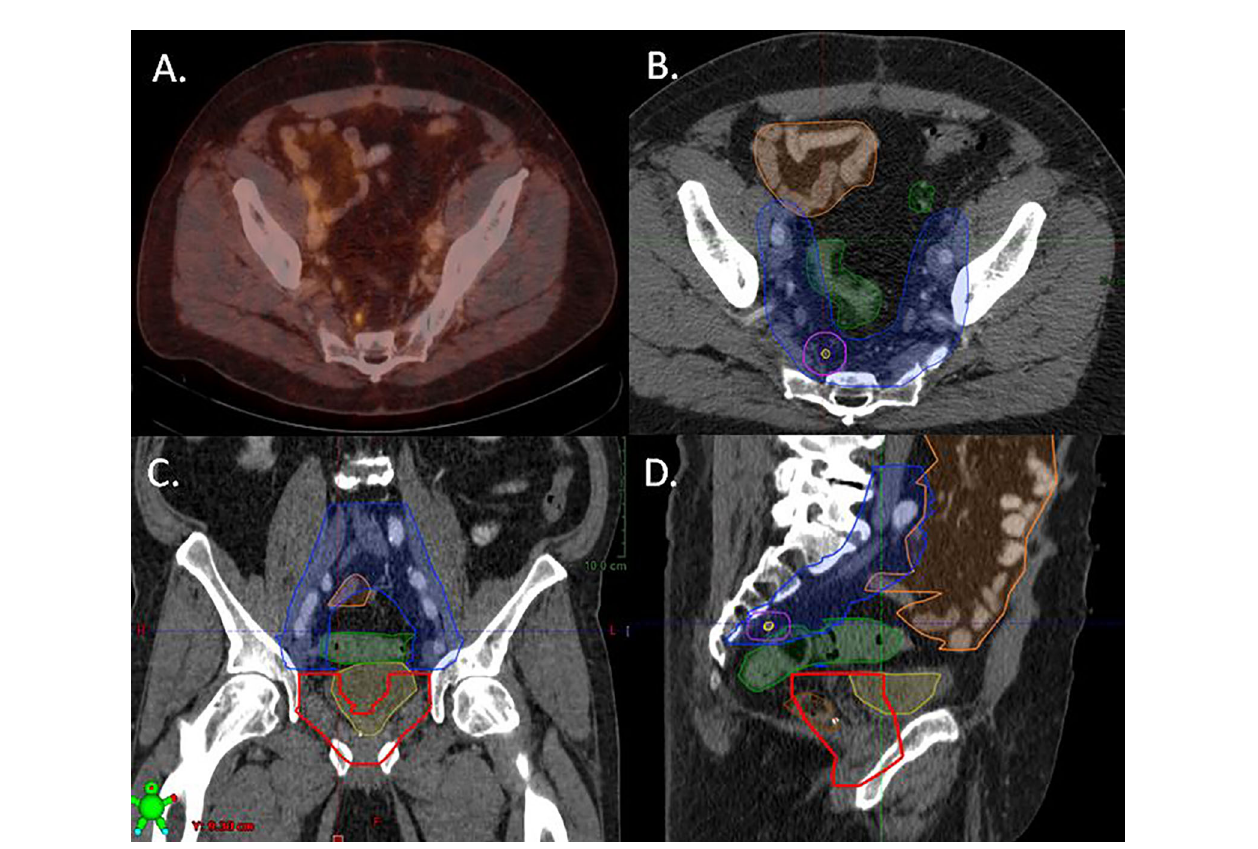
FIGURE 1 | Treatment plan of a patient with a presacral lymph node recurrence on PSMA-PET/CT illustrating the different target volume concepts. The patient was treated with elective prostate bed RT (ePBRT) and elective bilateral lymphatic RT with dose escalation to the PET/CT positive lymph node (PDRT). (A) Fused PET/CT image, (B) axial plain, (C) coronar plain, (D) sagittal plain. Yellow line: PSMA-PET/CT positive lymph node; lila line: planning target volume for PSMA-PET/CT positive lymph node; Blue line: elective lymph node RT volume including presacral and bilateral internal iliac nodes; red line: elective prostate bed RT; Green line: organ at risk (sigma); Orange line: organ at risk (small